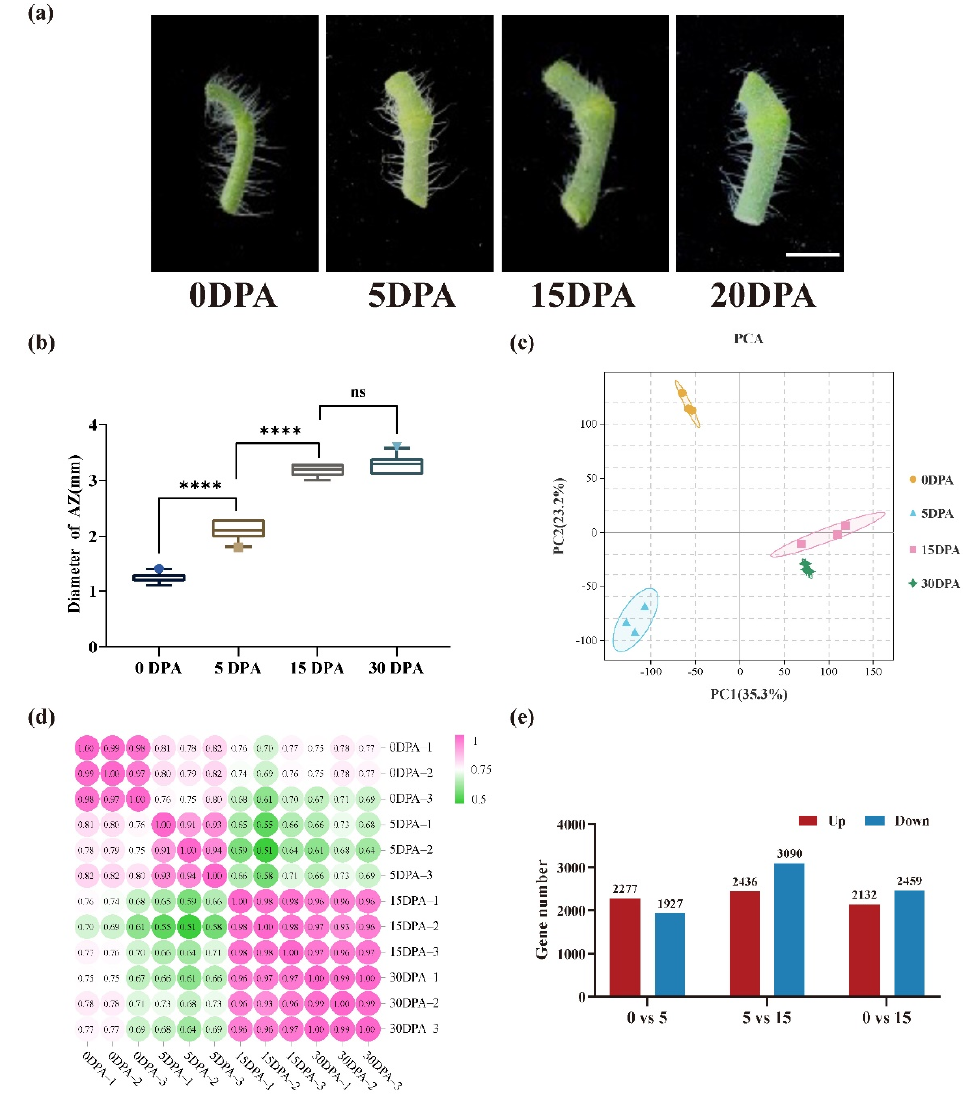
Figure 1. Tomato pedicels, AZ size, and transcriptome analysis between different development stages. DPA, days post-anthesis. ( a ) The development of tomato pedicels. ( b ) AZ diameter in different developmental stages: ****, extremely significant (p < 0.0001); ns, no significance. ( c ) Principal component analysis of the transcriptome samples. ( d ) Correlation analysis between the twelve samples. ( e ) Number of differentially expressed genes in three different comparisons.